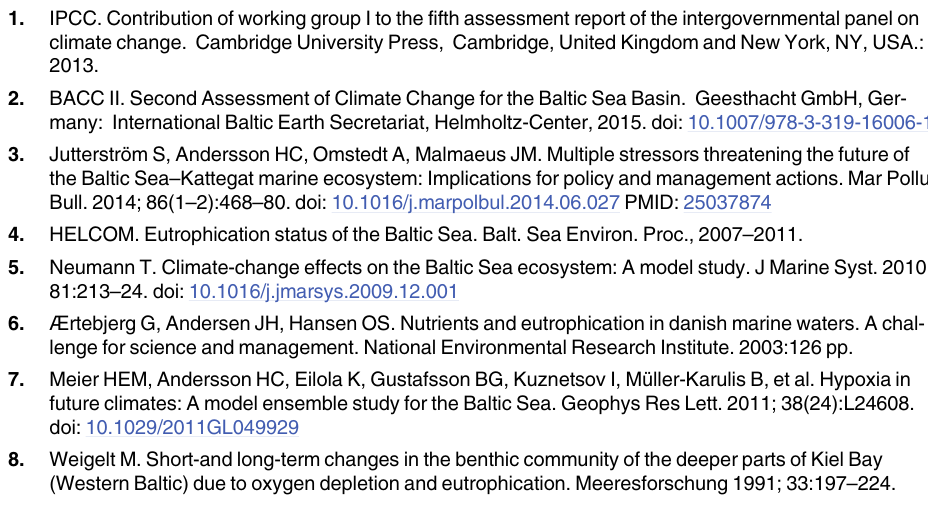
S1 Fig. Nutrient concentrations in the experimental boxes. Nutrient concentrations within the experimental germling boxes before (A, B) and after (C, D) the bi-weekly addition of the , NO , NO ) as well as initial NH conditions in μ mol L -1 in July and August. nutrients (PO 4 3 2 4 Initial nutrient concentrations were measured six times per month in the main KOB tank before the water addition to the boxes. Nutrient concentrations after additions were deter- mined by adding the sum of the initial and additional nutrient